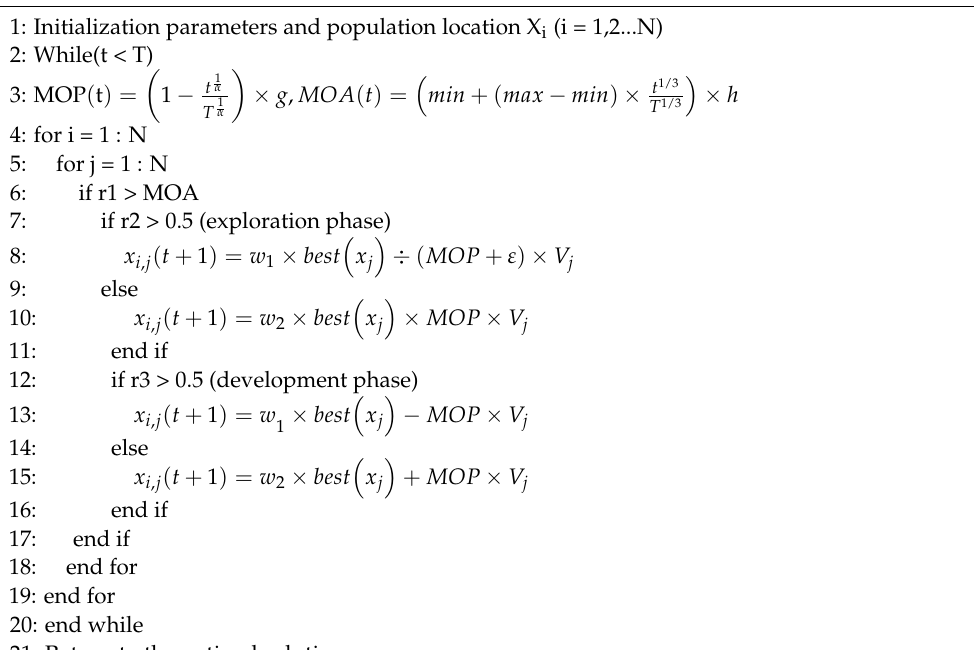
Algorithm 1. Pseudo-code of the